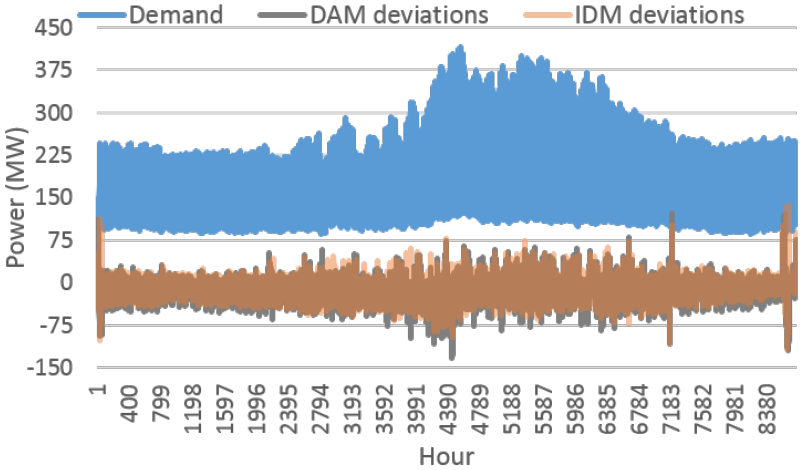
Figure 1. DAM and IDM deviations in relation to real consumption. Brown lines consider the merge between DAM and IDM